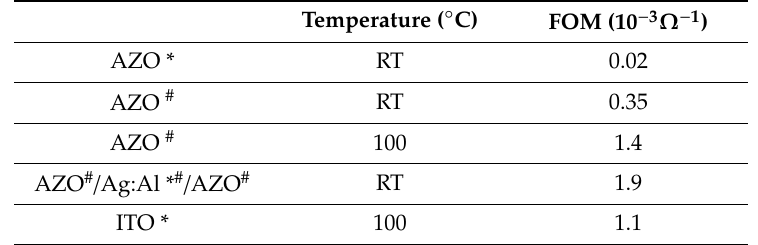
Table 1. Comparison of FOM values for thin films and the multi-layer structure fabricated. AZO / Ag:Al / AZO structures at room temperature show the highest FOM factor, which indicates the potential for transparent conducting